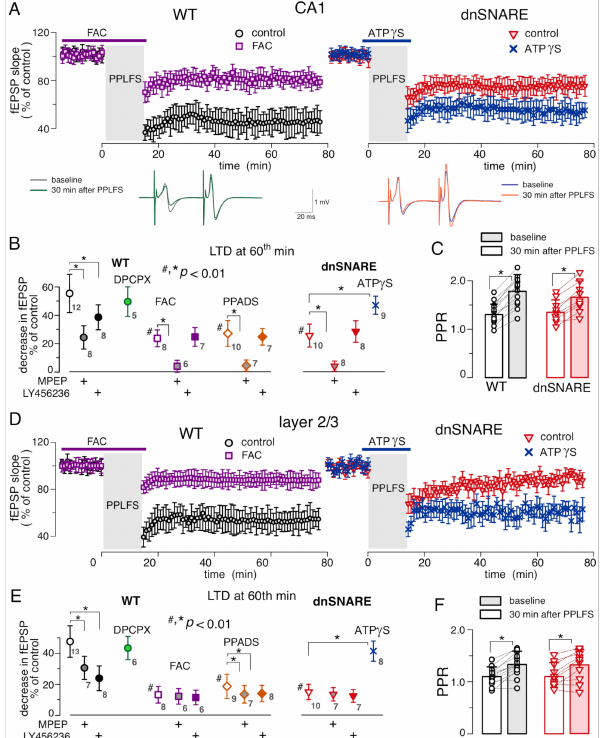
Figure 4. Gliotransmission and P2X receptors are essential for the mGluR-dependent LTD in the hippocampus and neocortex.( A ) The time course of changes in the field excitatory postsynaptic potential (fEPSP) in the CA1 region of the wild-type (left) and dnSNARE (right) mice induced by the paired-pulse low-frequency stimulation (PPLFS) under control conditions or in the presence of glial inhibitor FAC or P2X agonist ATP γ S. Dots show the average slope (relative to baseline) for 1 min window (6 fEPSPs); data are shown as mean ± SD for the number of experiments indicated in ( B ). The insets show the representative paired-pulse fEPSP waveforms (average of 10 fESPs) recorded in individual experiments immediately at the start (baseline) and 30 min after PPLFS in the control conditions. ( B ) Pooled data (mean ± SD) on the magnitude of LTD evaluated as relative decrease in the fEPSP slope at 60th min (after the PPLFS) in control and presence of inhibitors of mGluR, A1 and P2X receptors. Hash symbols (#) indicate the statistical significance of difference in the LTD magnitude from wild-type control values (unpaired t -test), asterisks (*) indicate the significance of the effect of mGluR antagonists and other drugs compared to the control of the same genotype. ( C ) The changes in the paired-pulse ratio (PPR) of the fEPSPs recorded in the WT and dnSNARE mice before and after PPLFS-induced LTD; points show individual experiments, bars show mean ± SD. Asterisks (*) indicated the statistical significance according to the paired t -test. ( D , E ) same experimental paradigm applied to the fEPSPs recorded in the somatosensory cortex layer 2/3 of WT and dnSNARE mice. ( C , F ) putative changes in the neurotransmitter release by comparing the paired-pulse ratio (PPR) of fEPSPs at before and 30 min after the PPLFS. Note the difference between CA1 and layer 2/3 neurons in respect of action of MPEP and LY456326, especially the lack of additive effect of FAC and PPADS in the neocortex. Additionally, note the increase in the paired-pulse ratio after PPLFS both in the CA1 and layer 2/3